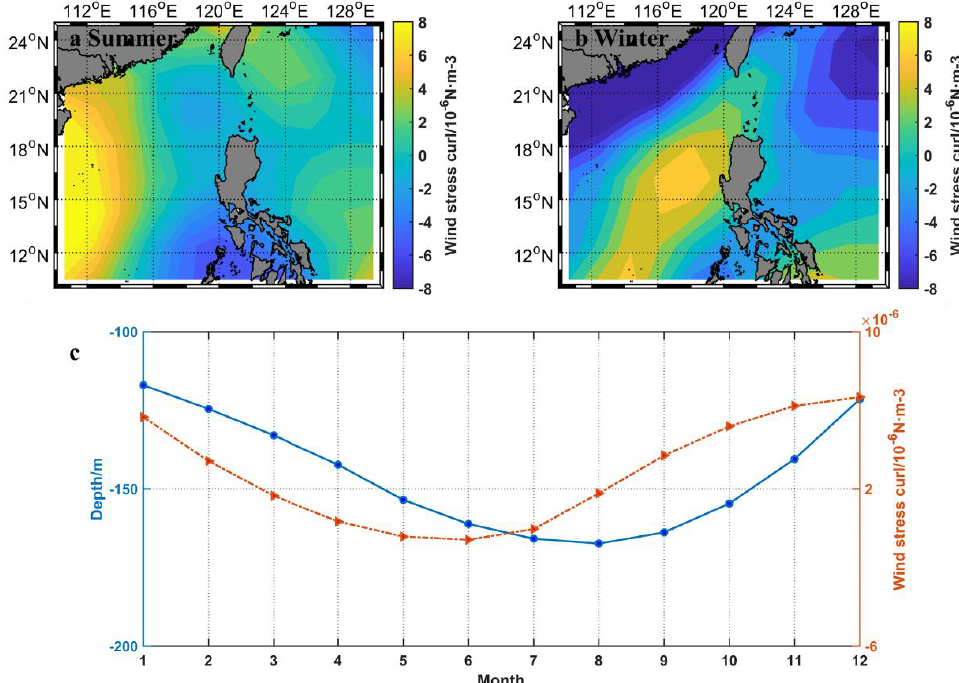
Figure 11. Mean wind stress curl derived from the National Centers for Environmental Prediction (NCEP) monthly Cli- matology Data: ( a ) Summer (June – August); ( b ) Winter (December – February). ( c ) Depth in the salinity-maximum layer (NCEP) monthly Climatology Data: ( a ) Summer (June–August); ( b ) Winter (December–February). ( c ) (blue line, averaged in the 14 – 19° N and 115 – 120° E box) and wind stress curl (red line) as a function of calendar month. Depth in the salinity-maximum layer (blue line, averaged in the 14–19 ◦ N and 115–120 ◦ E box) and wind stress curl (red line) as a function of calendar